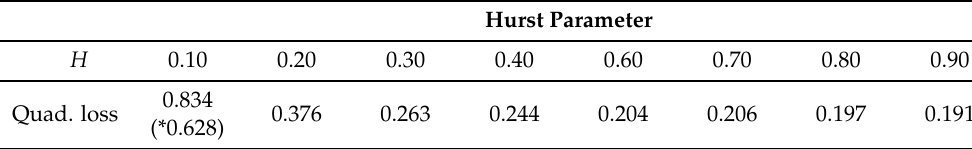
Table 2. Quadratic loss for different Hurst parameters. Run time on 75 epochs was approximately 2 h for each